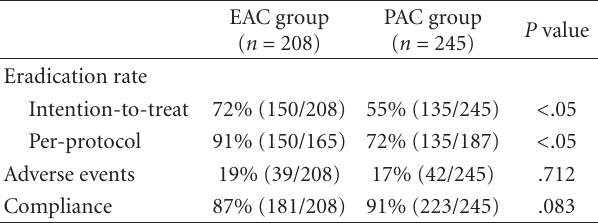
Table 2: Outcomes of esomeprazole- and pantoprazole-based triple therapy.